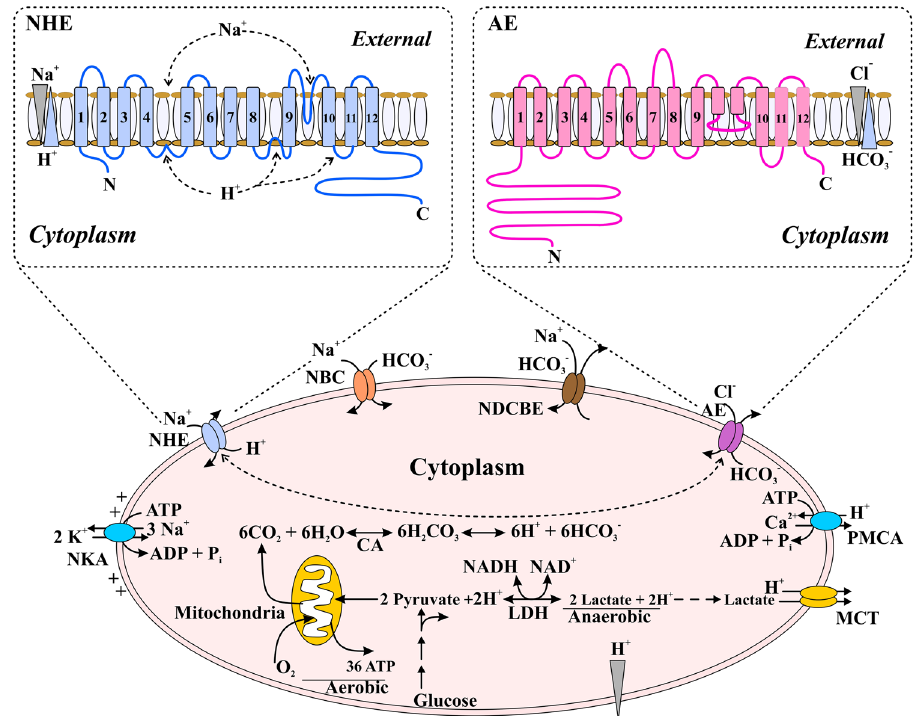
Fig. 5 The regulation of cytoplasmic pH by ion carriers in algal metabolism. The cytoplasm tends to be acidi fi ed via various metabolic activities/pathways, i.e., oxidative phosphorylation in mitochondria that produces CO 2 (the aerobic component in the fi gure) and ATP production by glycolysis that generates lactate (the anaerobic component in the fi gure). pH transporters (Na + – HCO 3 − cotransporters [NBCs] and Na + – H + exchangers [NHEs]) are critical for plasma membrane alkalinization. These transporters consume energy that has been stored in electrochemical Na + gradient, which is established by (NKA) Na + – K + ATPase pumps to drive solute transport. These (alkaline) mechanisms are balanced by the activities of PM Cl − – HCO acidify the cell. PM Ca 2 + ATPases (PMCAs), which exchange H + in the cytosol with extracellular H + , further acidifying cytosolic components to elevate the intracellular Ca 2 + level. In cells, alkalinization may be favored by MCT monocarboxylate H + cotransporters. The NHE and AE proteins are shown in the insets, and carbonic anhydrase (CA), lactate dehydrogenase (LDH), cytosol pH, pH c , pH o , and extracellular (or outside) pH are